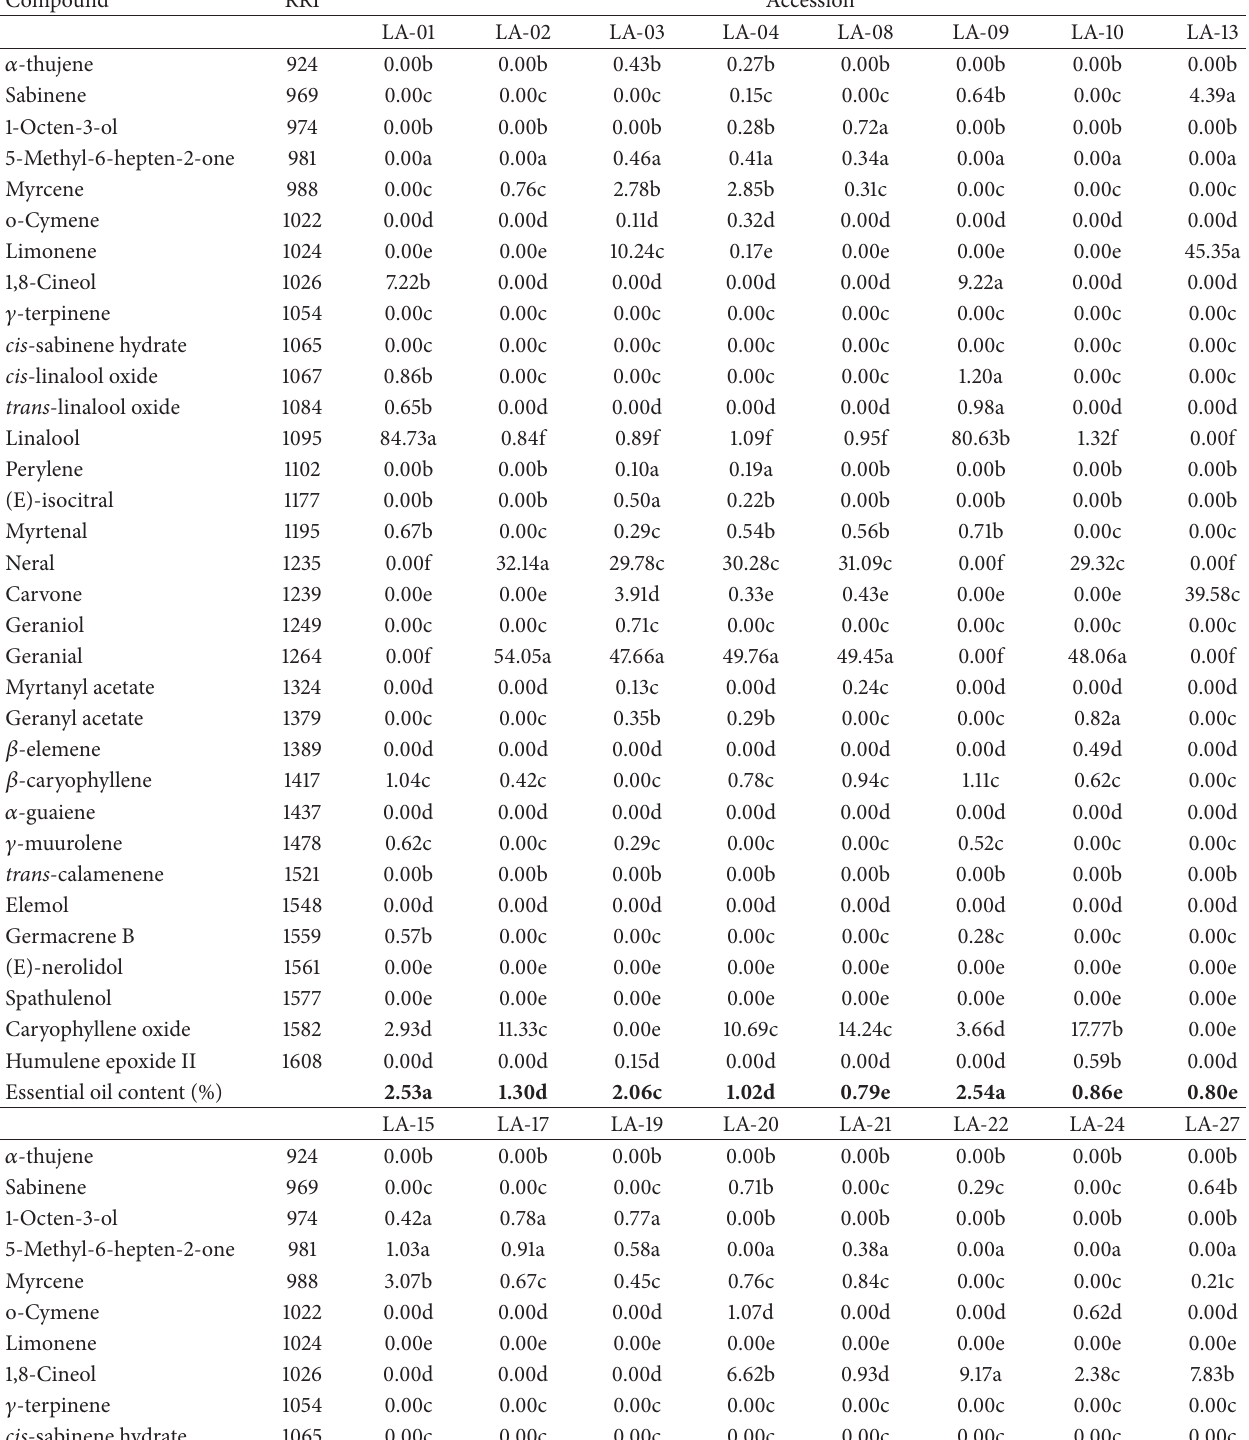
Table 2: Chemical composition of the essential oil of L. alba accessions from the Active Germplasm Bank at the Federal University of Sergipe.